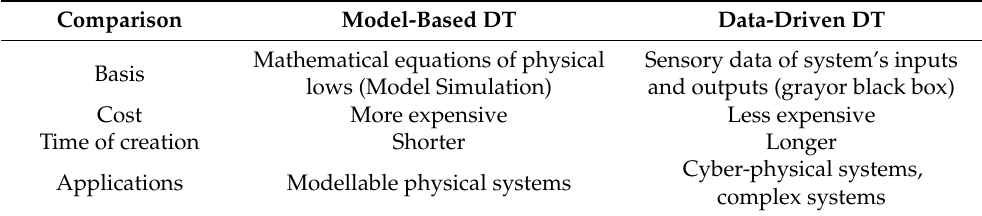
Table 1. Comparison between model-based and data-driven DTs from different perspectives. Comparison Model-Based DT Data-Driven DT Mathematical equations of physical Sensory data of system’s inputs Basis lows (Model Simulation) and outputs (grayor black box) Cost More expensive Less expensive Time of creation Shorter Longer Cyber-physical systems, Applications Modellable physical systems complex